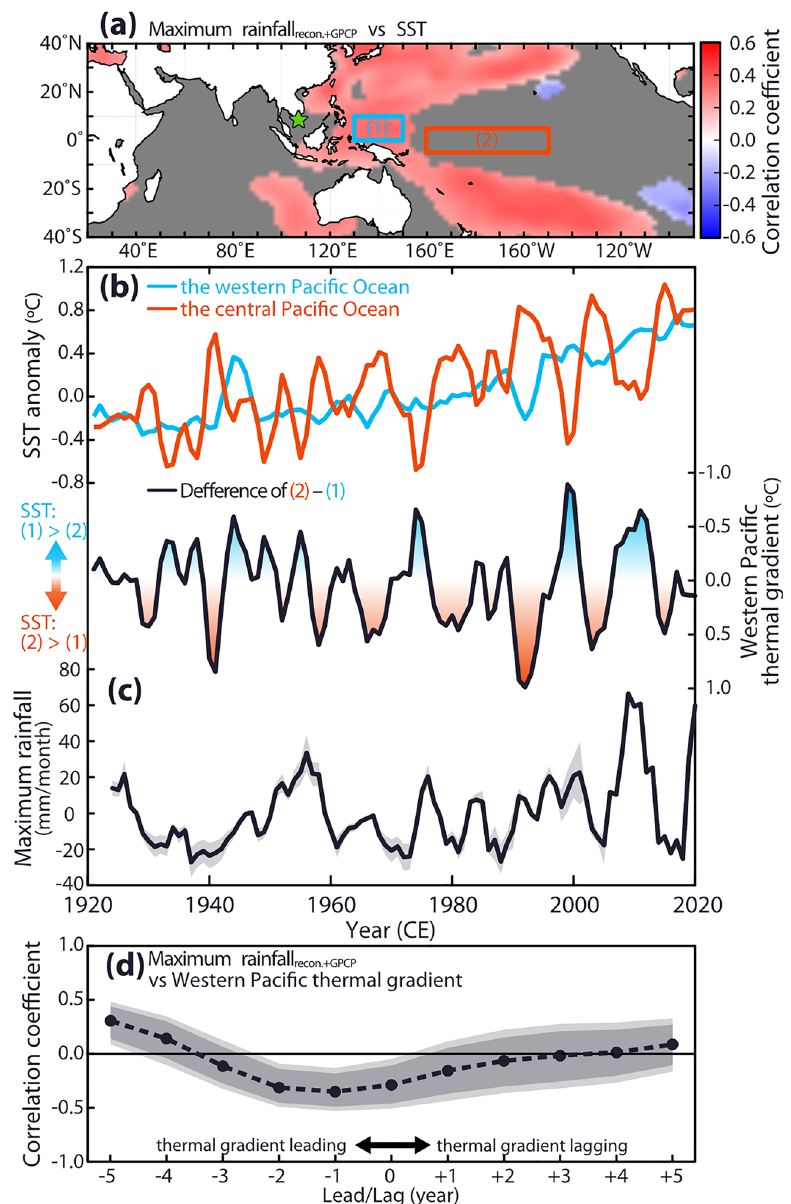
Figure 4. Comparing the maximum rainfall with SST in the Pacific Ocean. ( a ) A field correlation of the maximum rainfall recon+GPCP and SST (Extended Reconstructed Sea Surface Temperature, ERSSTv5 48 ) during 1924–2020 CE. Note the positive correlation in the western Pacific Ocean (blue box) and insignificant correlation in the CP region (red box). A green star indicates our sample site. The map was generated by the GMT 4.5.12 46 . Correlations were computed with the web application KNMI Climate explorer. Correlations not significant at the 10% level are masked out. ( b ) The upper panel indicates 3-year moving averages of the SST anomaly in the western (blue line; a blue box in panel a ) and central Pacific Ocean (red line; a red box in panel a ). SST data are derived from ERSSTv5 48 . The lower panel indicates the western Pacific thermal gradient. ( c ) The maximum rainfall recon+GPCP (black line). Grey shades indicate the 90% confidence interval. ( d ) A lead-lag correlation analysis between the western Pacific thermal gradient and the maximum rainfall recon+GPCP . Shaded areas indicate the confidence bands of correlation coefficients (light colour: 99%; thick colour: